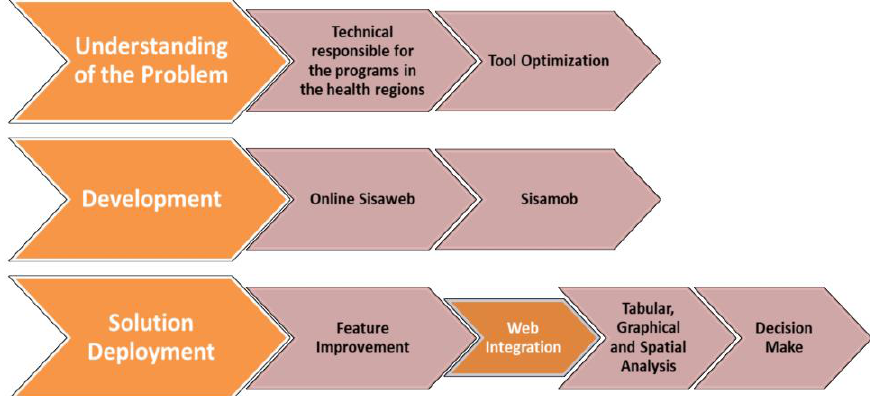
Figure 1 . SisaMob application development stages. Figure 1. SisaMob application development stages.